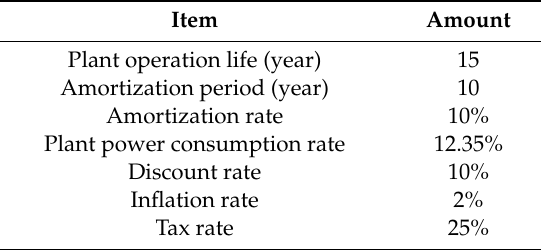
Table 2. Major economic assumptions.